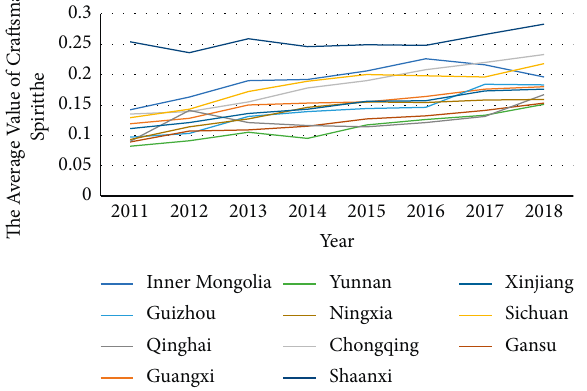
Figure 5: The trend of the average value of craftsman’s spirit in the construction industry in the western regions from 2011 to 2018. Table 3: National model setting test table.